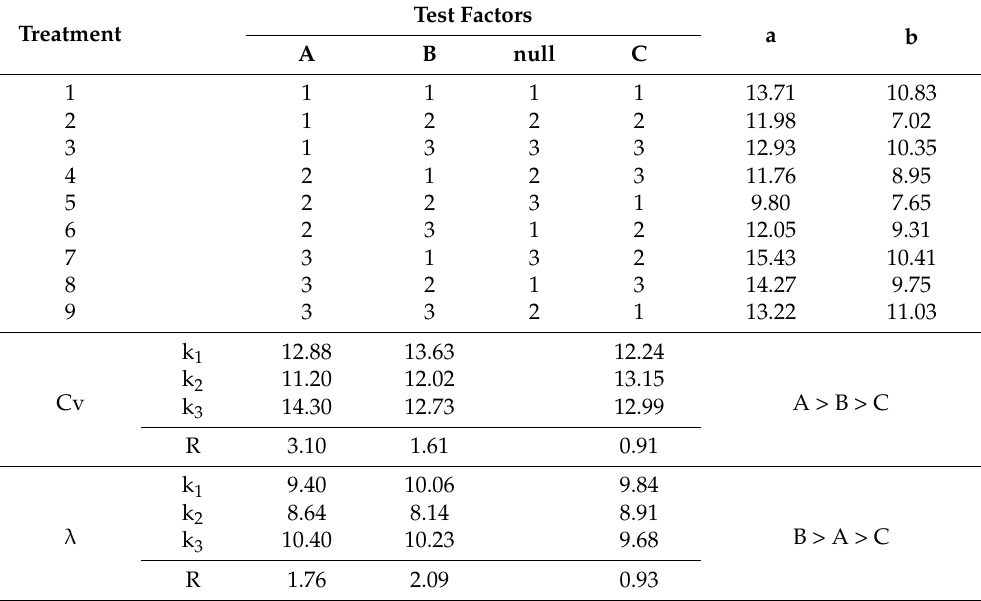
Table 7. Orthogonal test design and